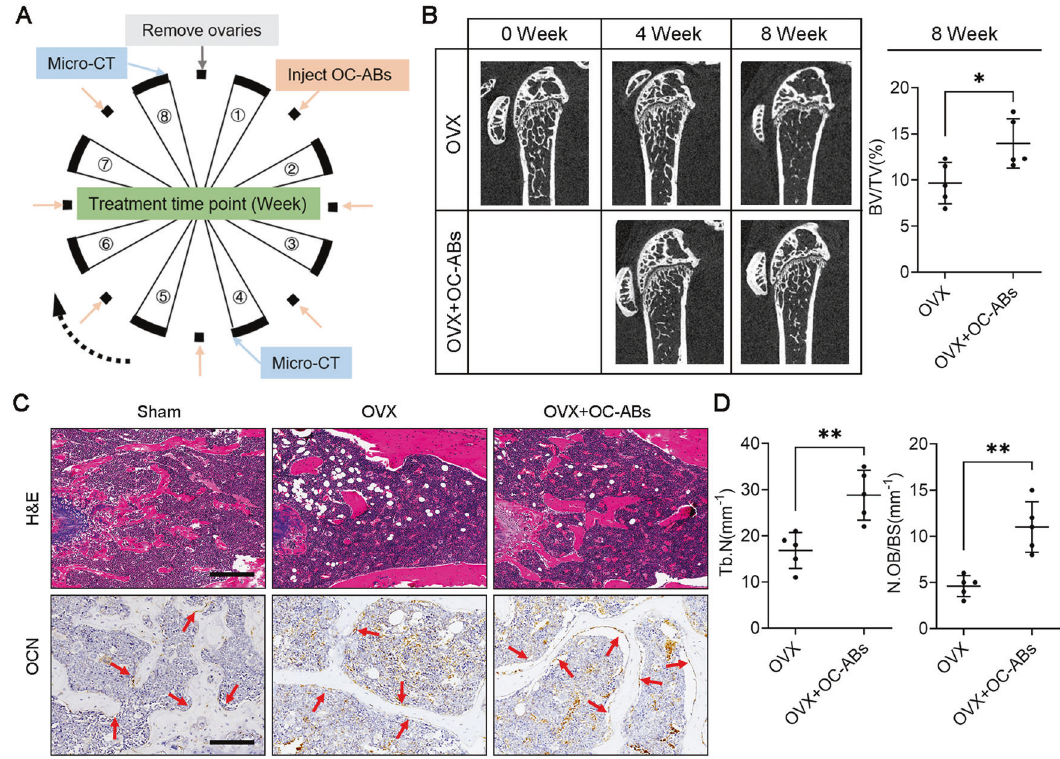
Fig. 6 Systemic infusion of OC-ABs delays osteoporosis progression in postmenopausal mice. A Experimental design to explore osteoporosis progression under apoptotic body supplementation (infusion via the tail vein, 4 × 10 6 OC-ABs/each time). B Representative micro-CT images and quanti fi cation of bone volume fraction from indicated mice femoral. C Representative H&E staining images and OCN immunohistochemical images of tibia from the indicated group of mice, scare bar = 100 μ m. D Quanti fi cation of trabecular bone (Tb.N) and osteoblasts (N.OB/BS) on bone surface, n = 5. The data in each panel represent the means ± SD. p values were obtained by student ’ s two-tailed unpaired t test, * p < 0.05, ** p < 0.01, ns non-signi fi